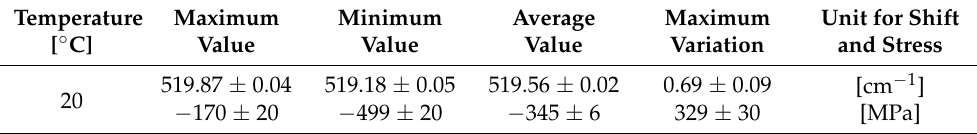
Table 8. Raman shift [cm − 1 ] and stress values [MPa] obtained for the B_AuSn sample.